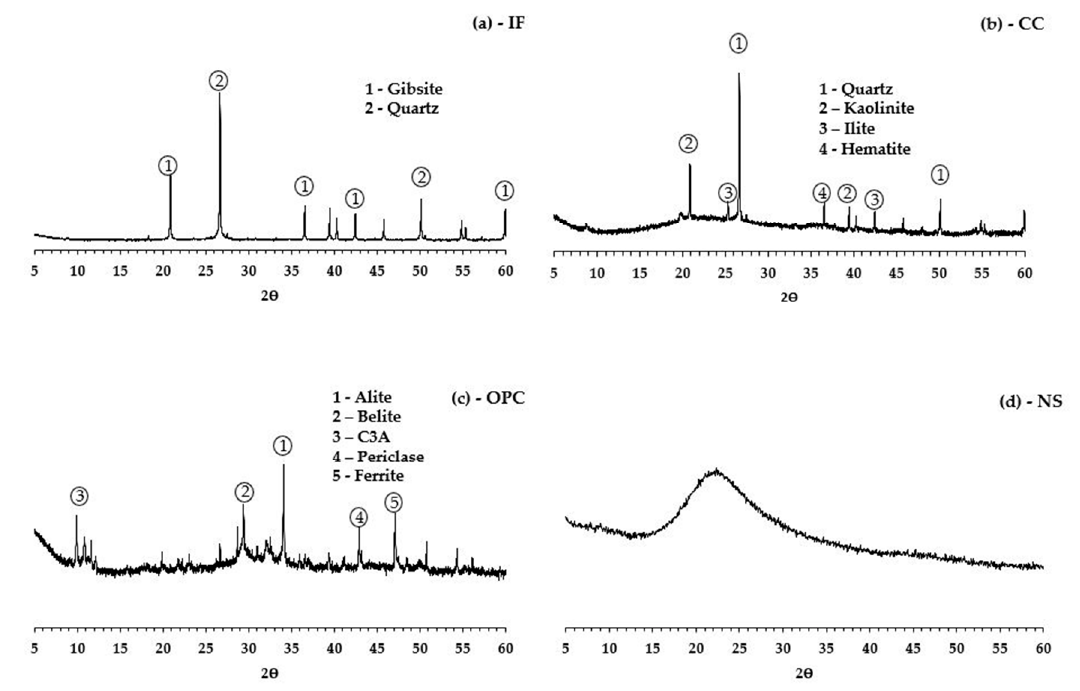
Figure 2. ( a ) XRD IF, ( b ) XRD CC, ( c ) XRD OPC, and ( d ) XRD NS. Table 2. Mass composition of the cement